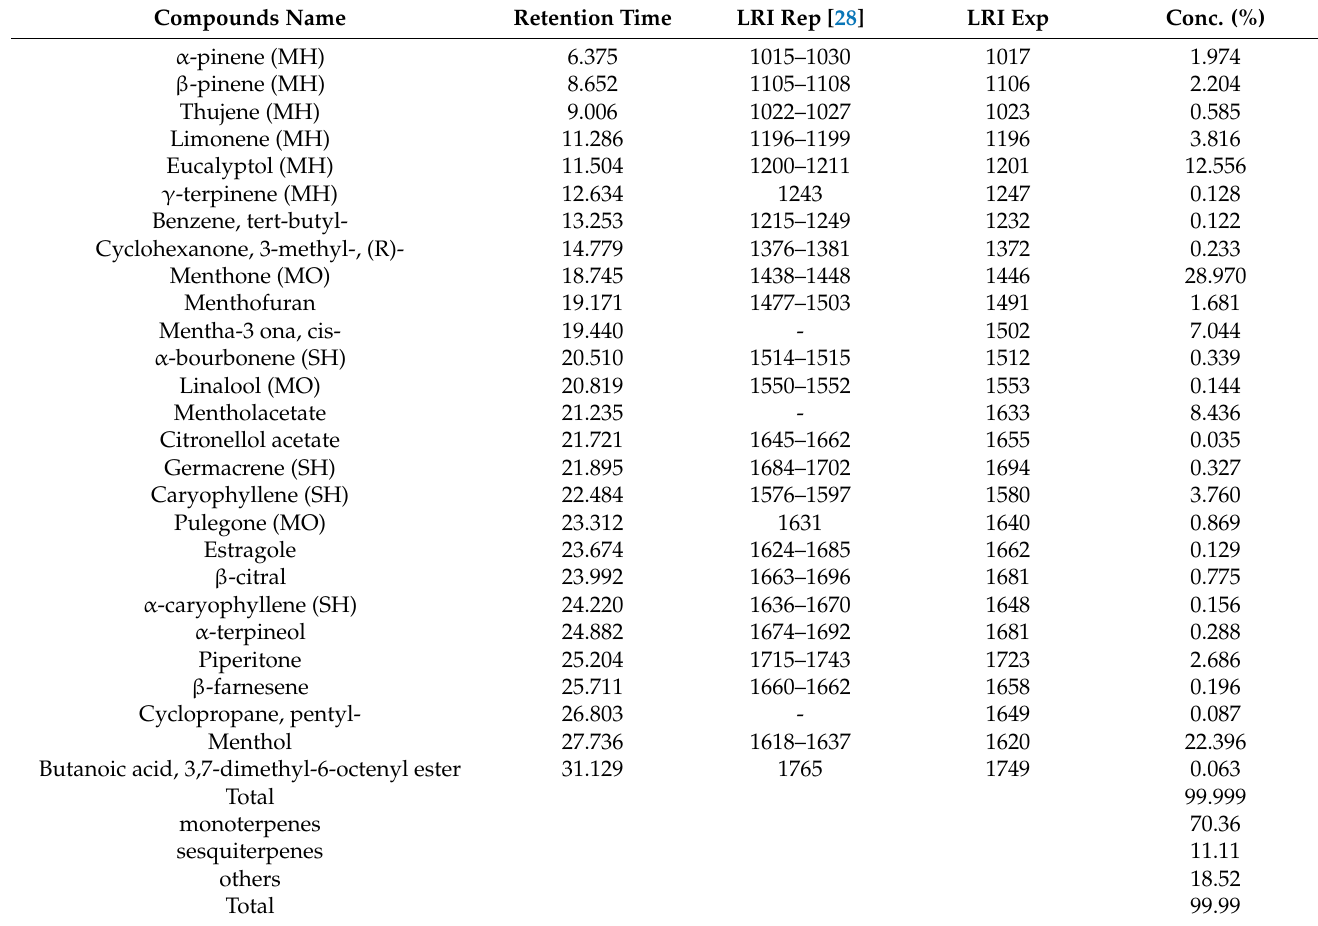
Table 1. The main phytochemical constituents of Mentha piperita L. essential oil identified by GC- MS